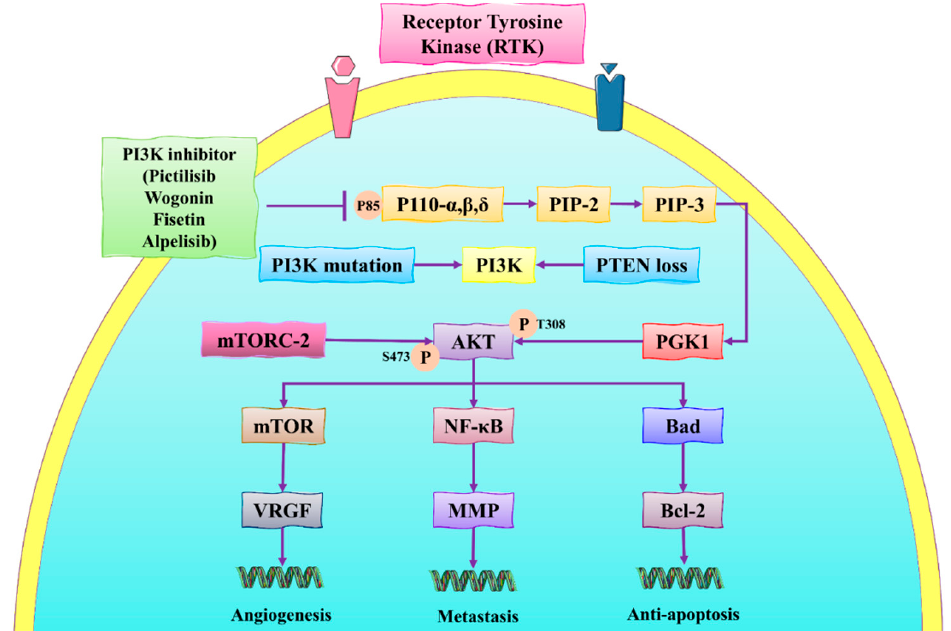
Figure 3. The schematic representation of the PI3K/Akt/mTOR signaling pathway in BC. VEGF: vascular endothelial growth factor; NF- κ B: nuclear factor kappa-B; EGF(R): epidermal growth factor (receptor); mTOR: mammalian target of rapamycin; PDK1/2: 3-phosphoinositide-dependent kinase- 1/2; PI3K: phosphatidylinositol 3-kinase; MMP: matrix metalloprotein; PIP-3: phosphatidylinositol (3,4,5)-trisphosphate; Bcl-2: B-cell lymphoma 2; mTORC-2: mTOR complex 2; VRGF: vascular endothelial growth factor; Bad: Bcl-2 antagonist of cell death. This figure is reproduced from Dong et al. [56] (Creative Commons Attribution License (CC BY 4.0)).